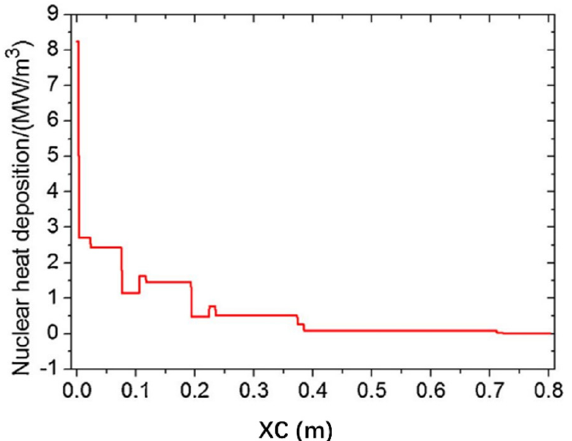
Figure 3. The nuclear-heat distribution along the XC direction (m). [3]. Reprinted with permission from [3]. Copyright 2016 Elsevier.